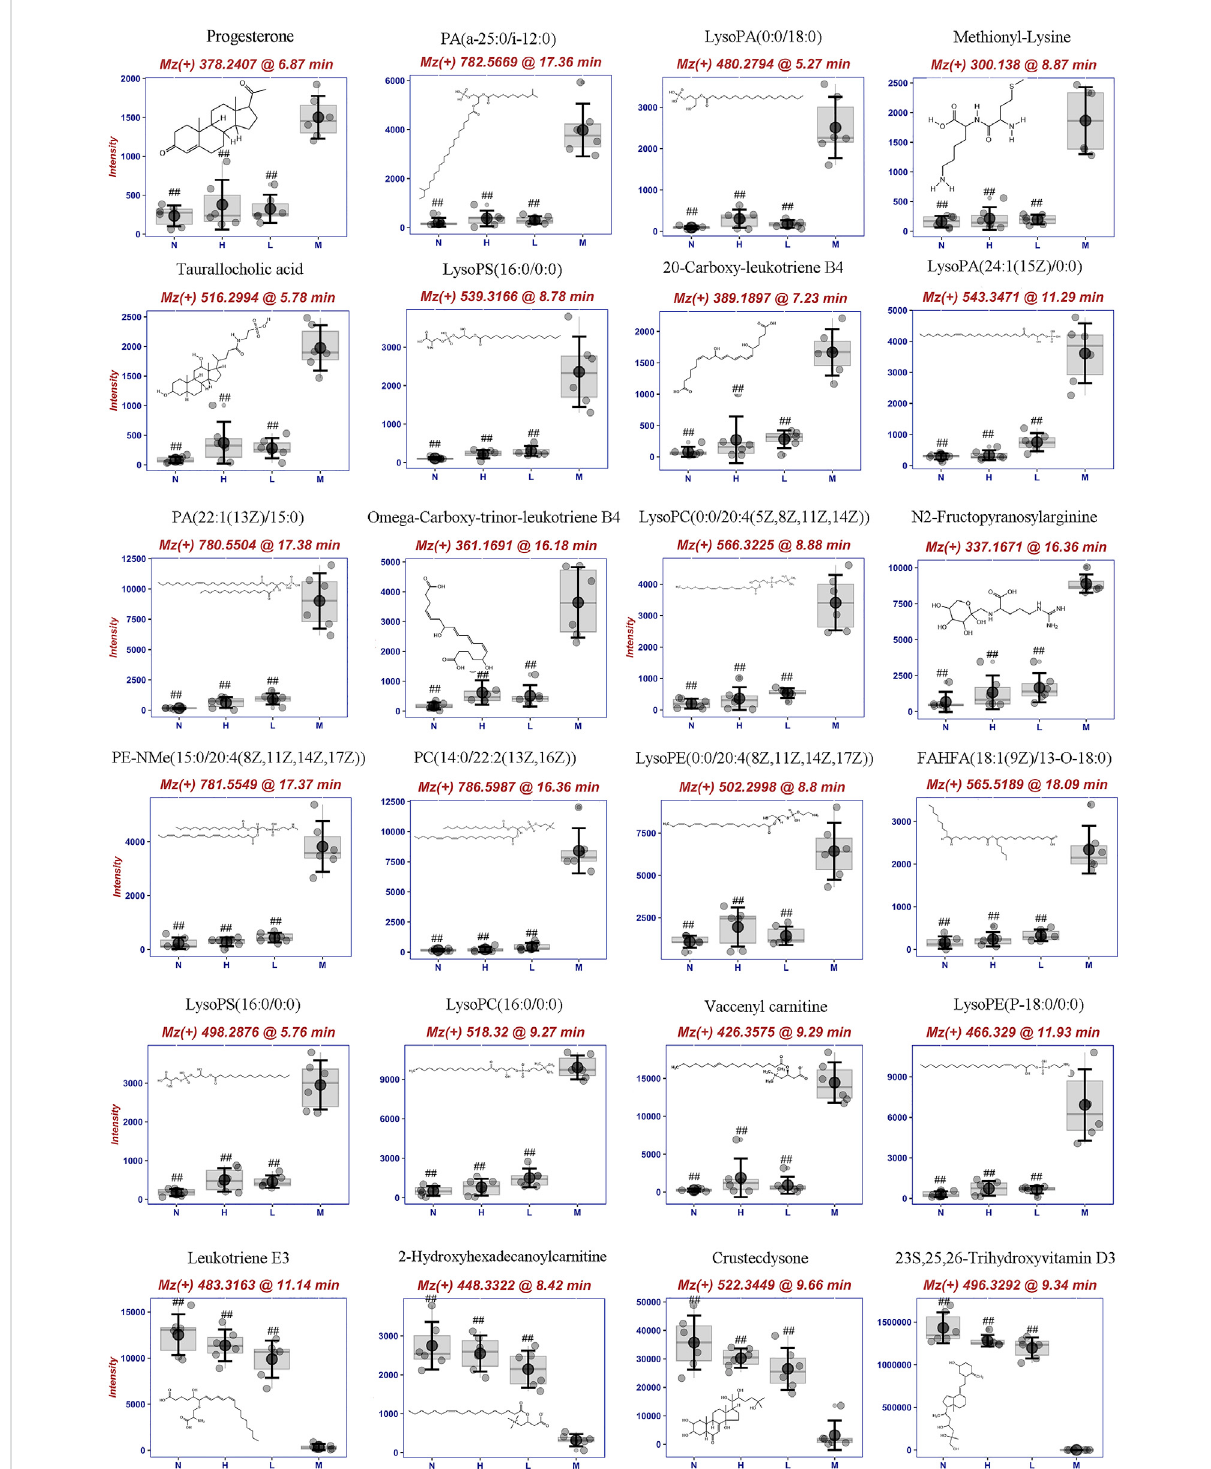
FIGURE 6 Metabolite biomarkers including structure, mz, retention time and its concentrion in four groups: normal (N), model (LPS 100 μ g/kg, M), low dosegroup(LPS100 μ g/kg+ AG20 mg/kg, L)andhighdose(LPS100 μ g/kg+AG40 mg/kg, H)group. # p < 0.05or ## p < 0.01 versusModel groupby